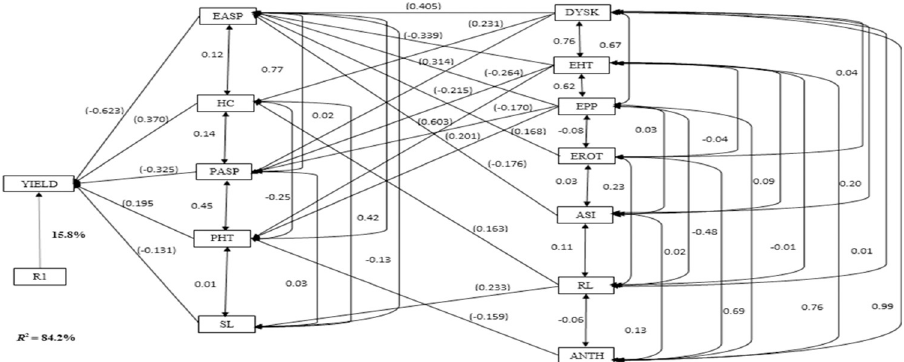
Fig 4. Path analysis model diagram showing causal relationships of measured traits of extra-early maturing provitamin A maize hybrids evaluated under optimal environments in Abuja, Ile-Ife and Mokwa. R 2 = co-efficient of determination; R1 = residual effects; YIELD = grain yield; EASP = ear aspect; EPP = ears per plant; ANTH = days to 50% anthesis; SL = stalk lodging; ASI = anthesis–silking interval; PASP = plant aspect; DYSK = days to 50% silking; PHT = plant height; EHT = ear height; HC = husk cover; RL = root lodging; EROT = ear rot.